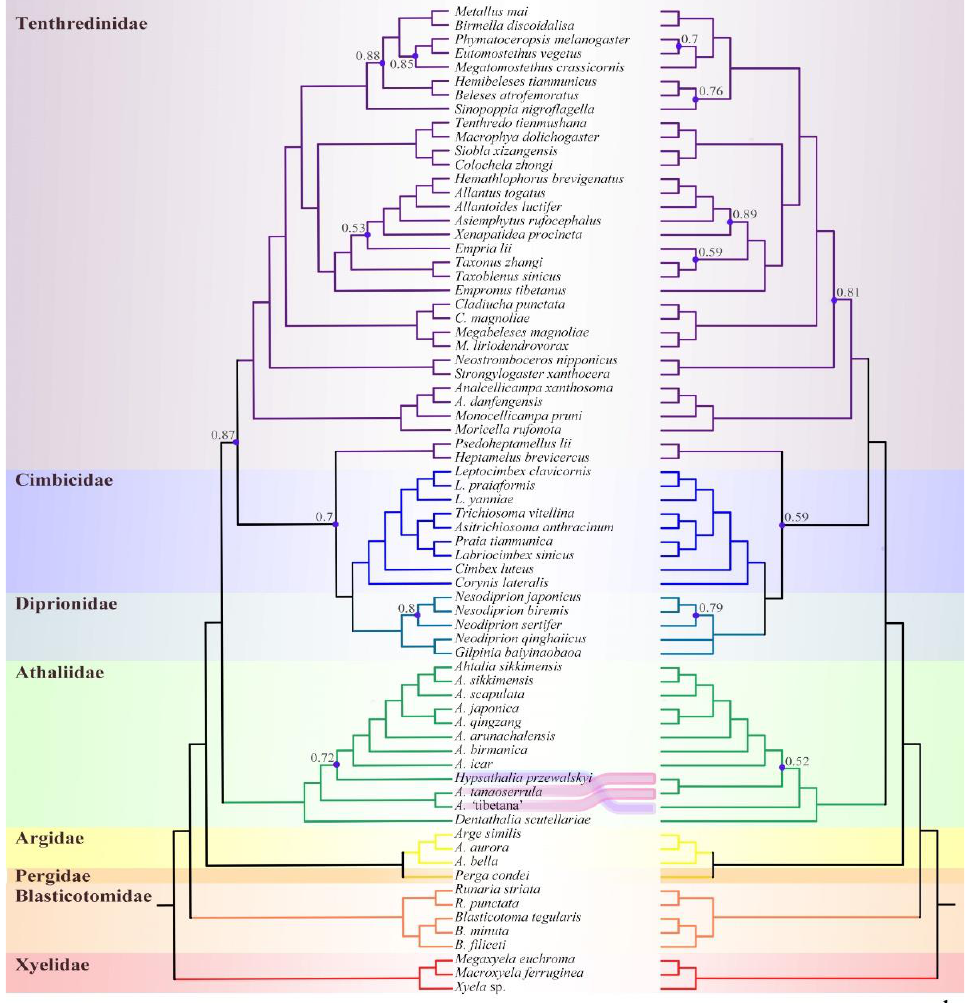
Figure 2. Topological comparison of PhyloBayes trees based on the concatenated amino acid matrix under ( a ) the CAT-GTR model and ( b ) the MtArt model, showing species group sampling and points of agreement and conflict. Posterior probability support values less than 0.90 are displayed on the trees with blue dots.